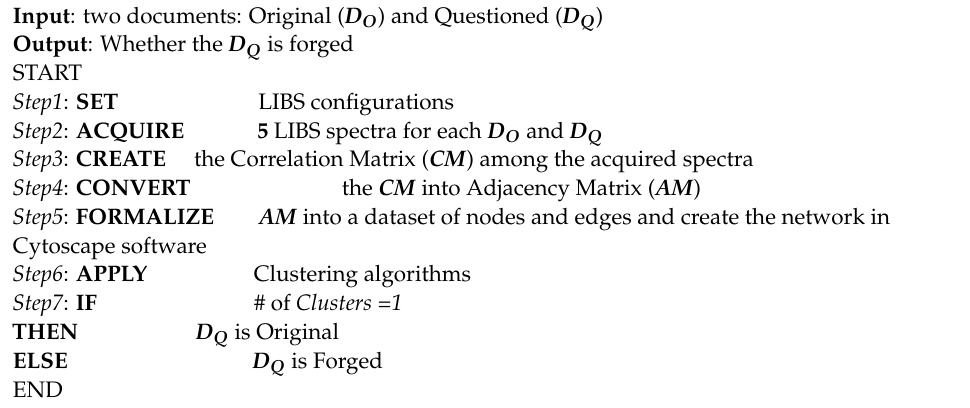
Algorithm 1: General workflow of the proposed